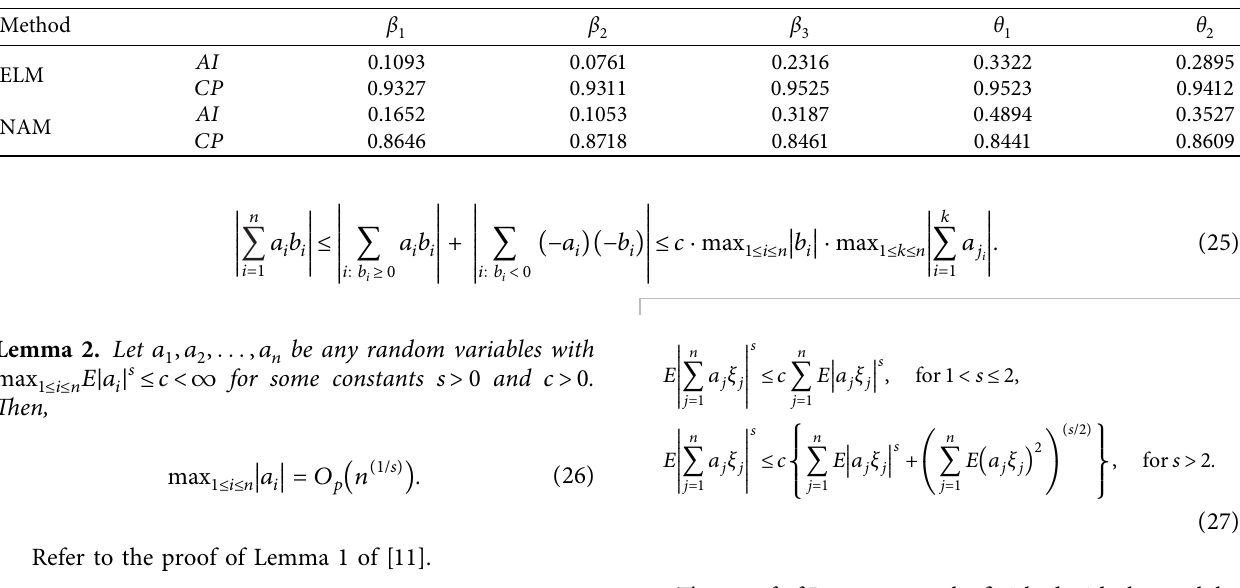
Figure 1: Simulation results of Example 1. Confidence region for ( β Table 2: Simulation results of Example 2. The average lengths (AI) and empirical coverage probabilities (CP) of the confidence intervals for , β , β , θ , and θ with sample size n � 200 when the nominal level is β 1 2 1 2 3